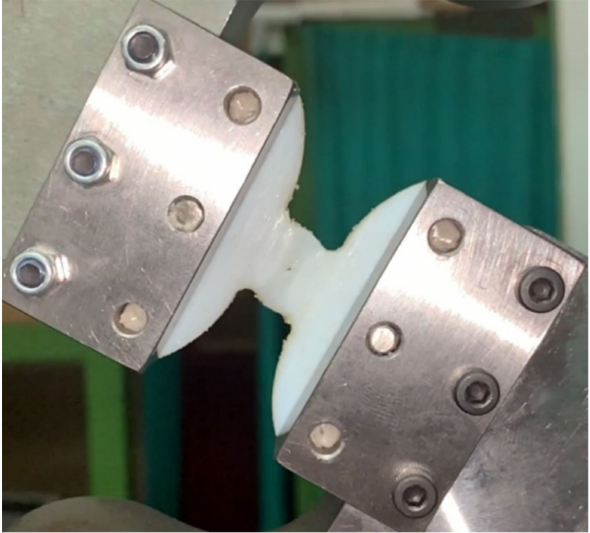
Figure 14. Void occurrence during Arcan